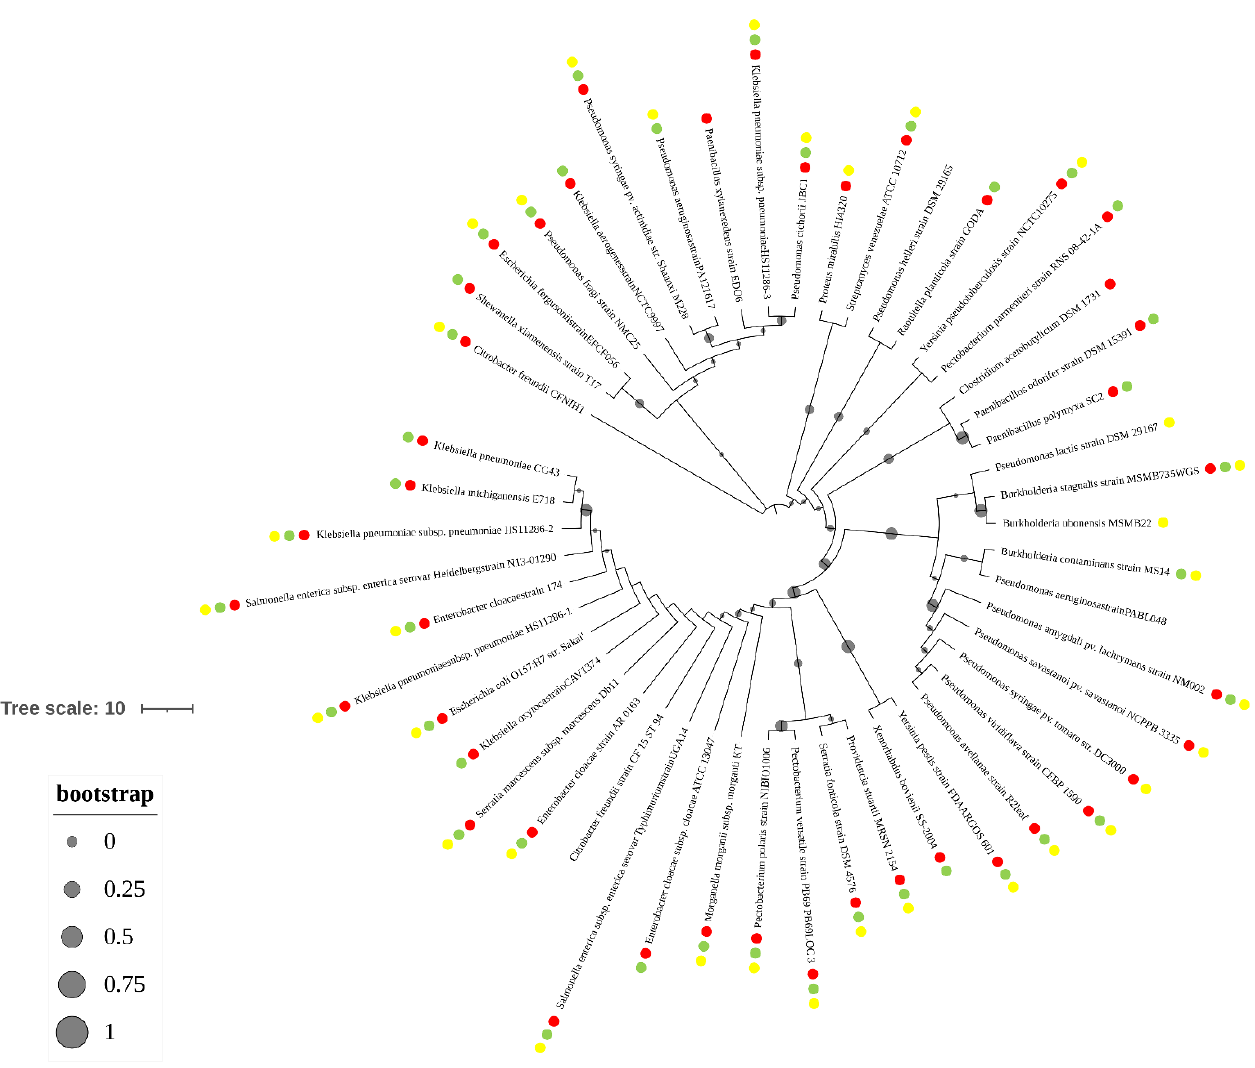
Figure 6. The phylogenetic and the co-existence analysis of terZABCDE gene cluster and the pathogen-related genes. The phylogenetic tree of terZABCDE gene cluster in different pathogenic bacteria was constructed in MEGA using the Neighbor-Joining method, and the bootstrap consensus tree was performed with 1000 replications. The existence of genes encoding siderophore, the virulence protein, and the type III secretion system are shown by the red points, green points, and yellow points.